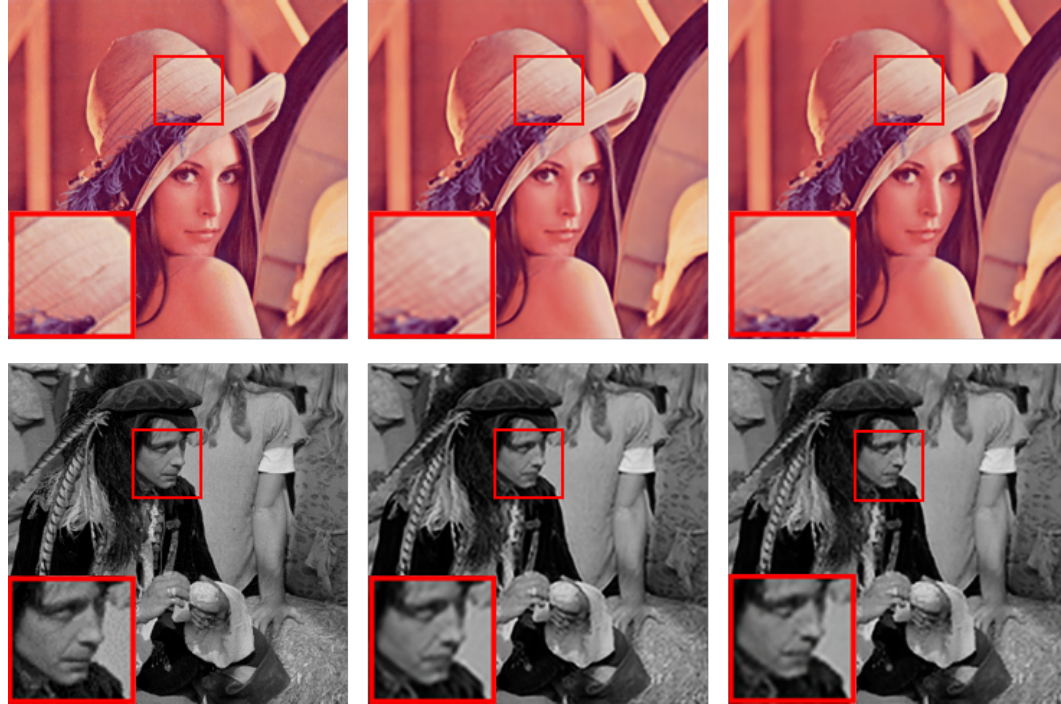
Figure 5. The ablation studies of perceptual metric for reconstruction. The images from left to right correspond to the ground truth, PM-DAN, and PM-DAN without the perceptual